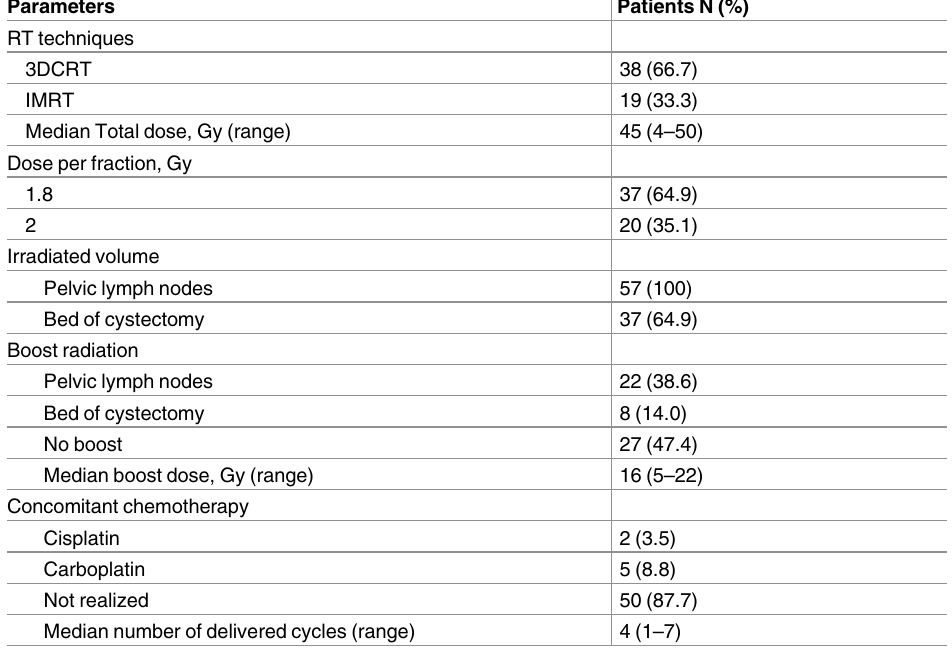
Table 3. Radiotherapy